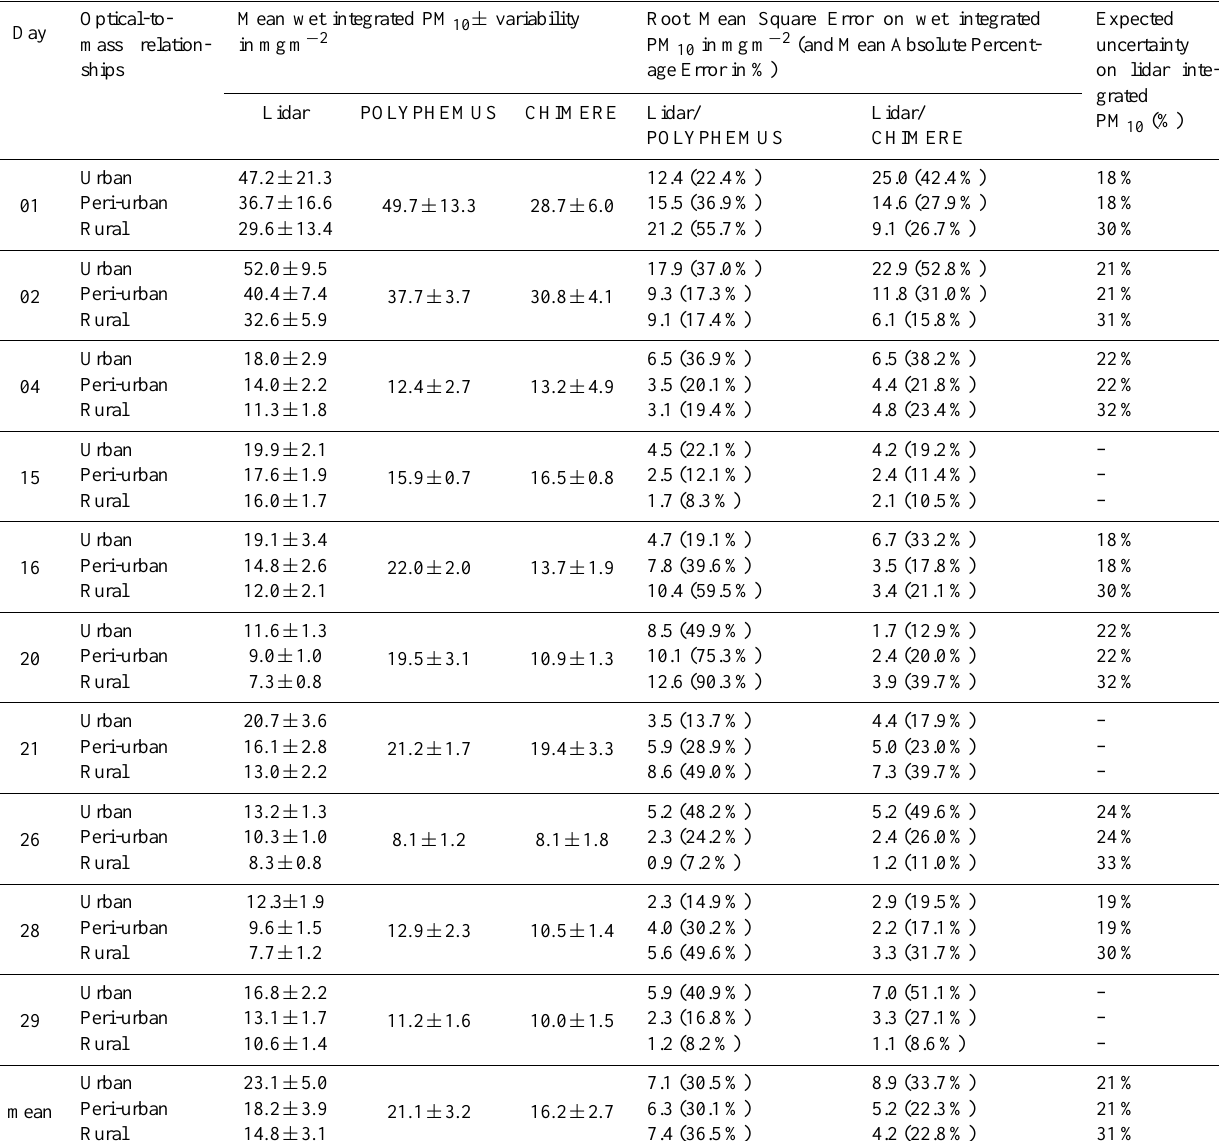
Table 7. Comparisons of wet integrated PM 10 between the ground level and 1km a.g.l. from GBML, POLYPHEMUS and